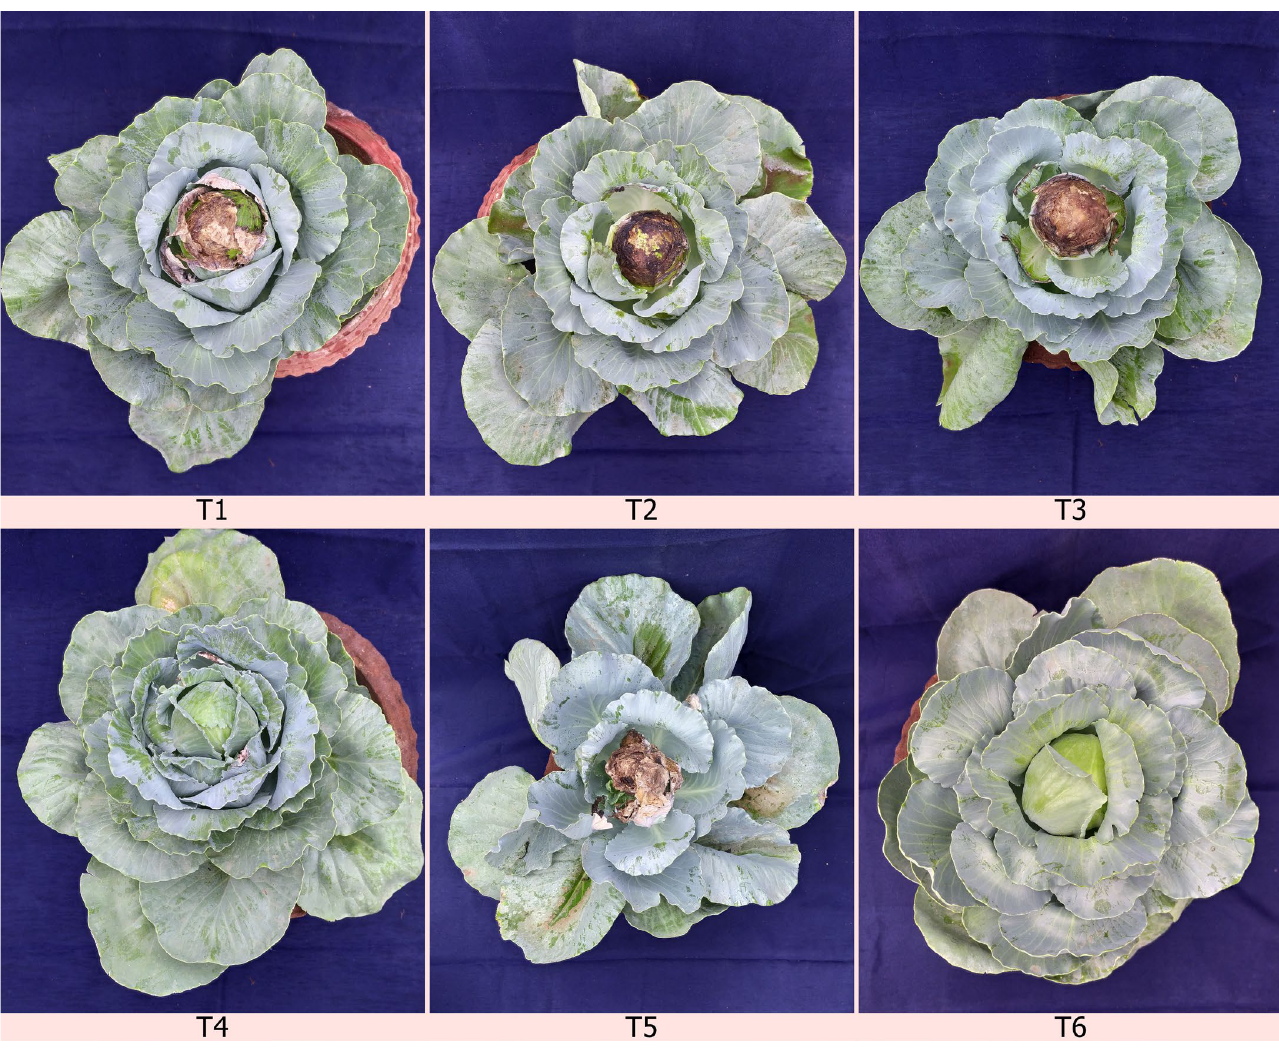
Figure 6. The effect on biocontrol agents on the severity of cabbage head rot under greenhouse con- ditions. ( T1 ) Foliar application of C. rosea TNAU-CR 02 at 5 mL/litre on 30, 45 and 60 DAT. ( T2 ) Foliar application of Trichoderma asperellum (TRI 15) at 5 mL/litre on 30, 45 and 60 DAT. ( T3 ) Foliar application of Bacillus subtilis (Bbv 57) at 5 mL/litre on 30, 45 and 60 DAT. ( T4 ) Tebuconazole + tri- floxystrobin application at 1.5 g/litre on 30, 45 and 60 DAT. ( T5 ) Inoculated control. ( T6 ) Uninocu- lated healthy control. Table 3. Efficacy of biocontrol agents on the severity of cabbage head rot pathogens under green- house conditions.